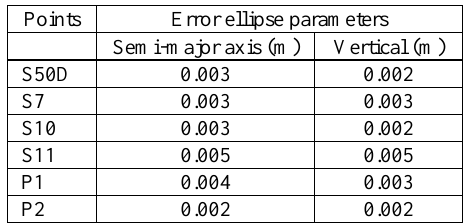
Table 3. Error ellipse parameters of the GPS point surveyed on